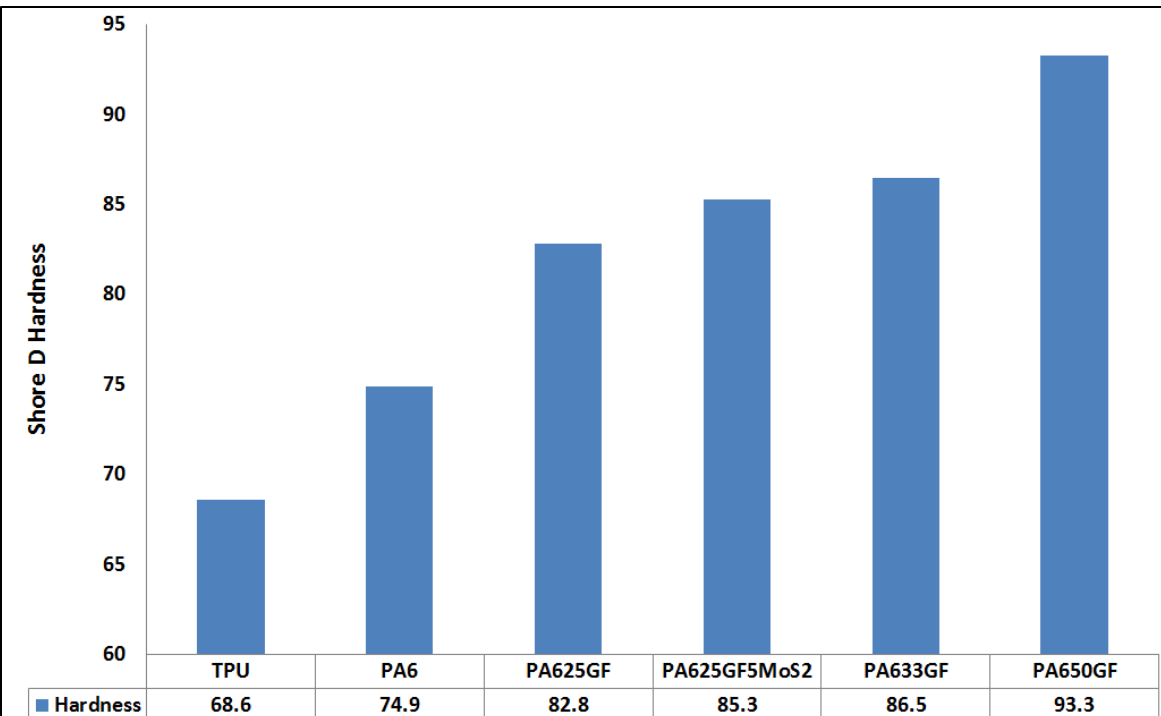
Figure 7. Shore D hardness values of the polymeric and composite samples.